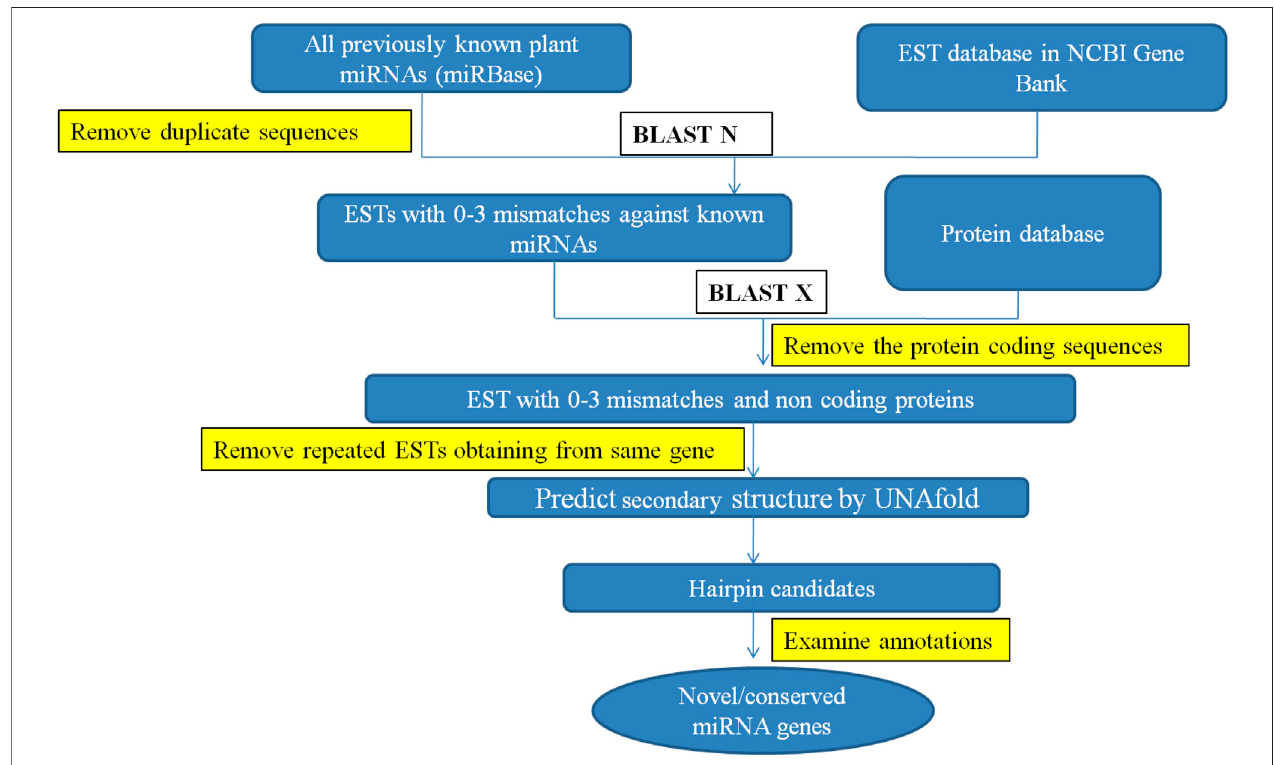
FIGURE 1 | Work fl ow for identi fi cation of miRNA and their targets in cluster